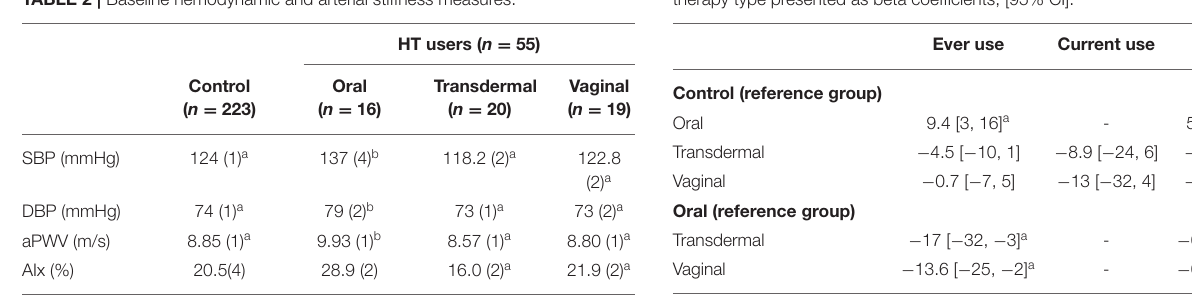
TABLE 2 | Baseline hemodynamic and arterial stiffness measures.